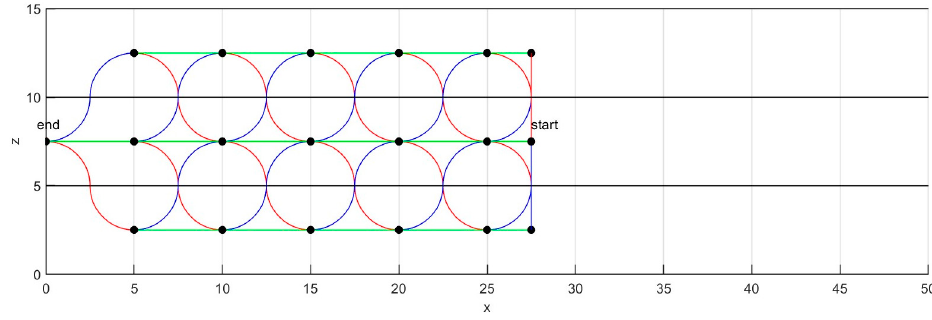
Figure 6. y-z view of Figure 5.